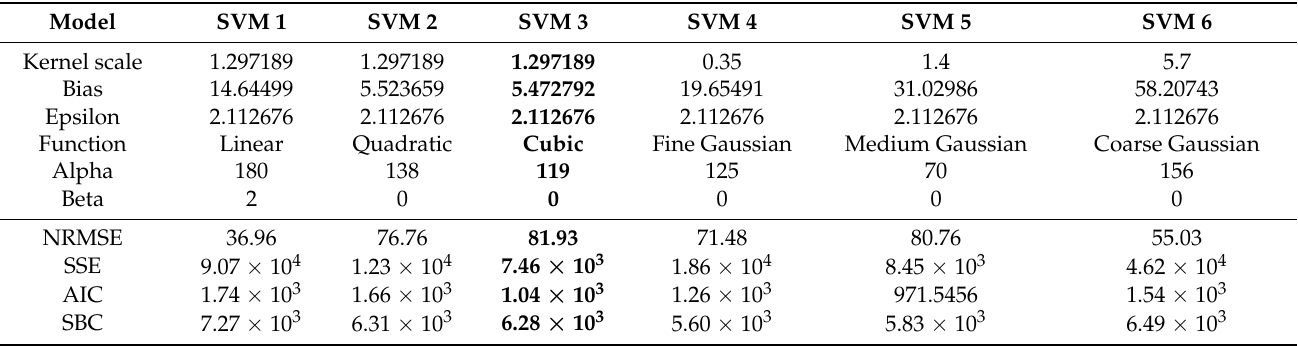
Table 14. Overview of the parameters of the created SVM models and performance metrics of the DMSP-5 muscle validation results.